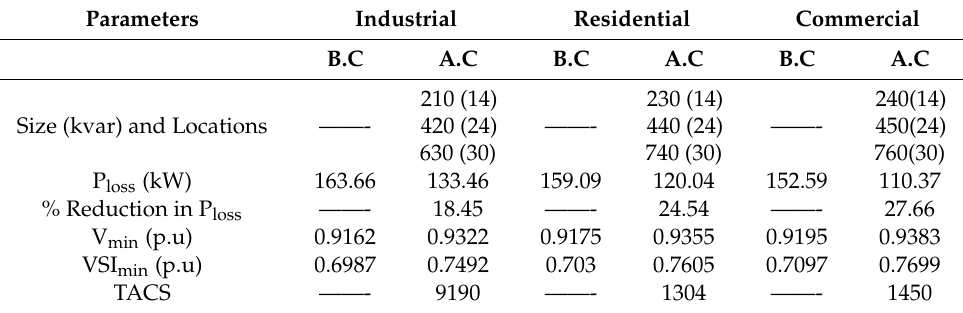
Table 3. Results of 33-bus system with di ff erent Load Models.